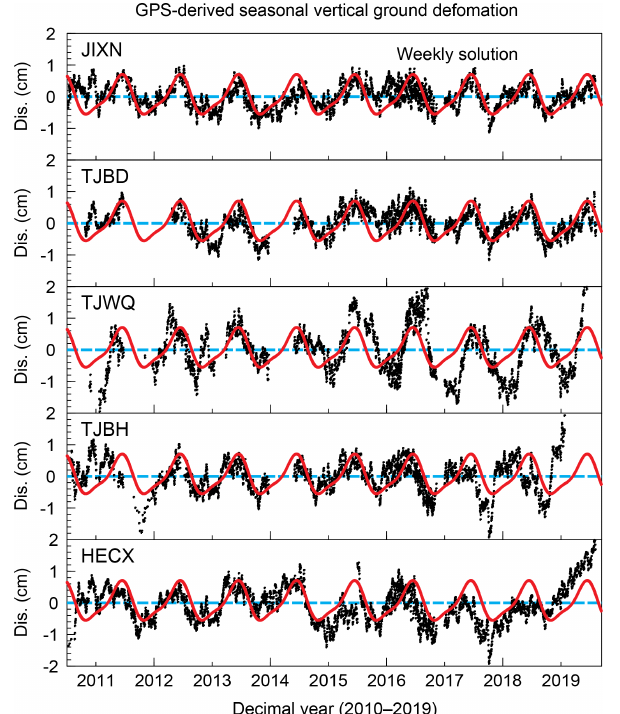
Figure 5. Comparisons of seasonal vertical ground deformation recorded by GPS (dark, 7d average) in Tianjin with the seasonal model (red, Eq. 1) for the north China